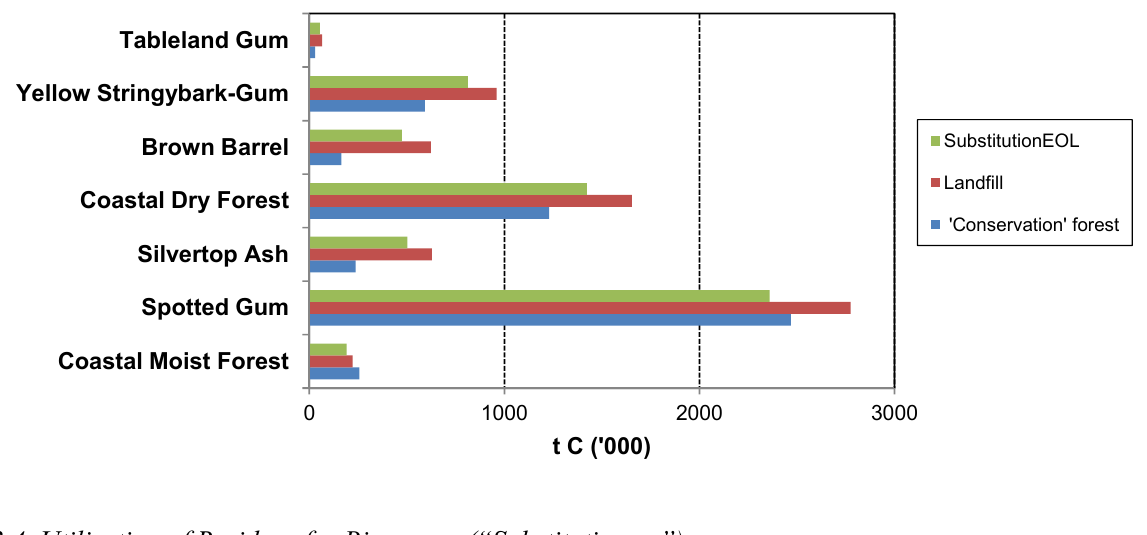
Figure 13. Total C mitigation benefits (t C) from the ‘Landfill” and “Substitution options for HWPs compared to the “ conservation ” scenario in the SC forest